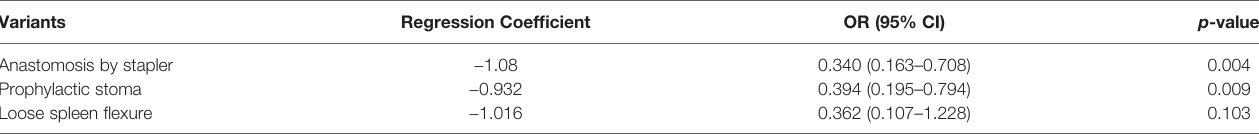
TABLE 1 | Multivariate analysis of postoperative anastomotic leakage of 563 cases after LA-taTME.